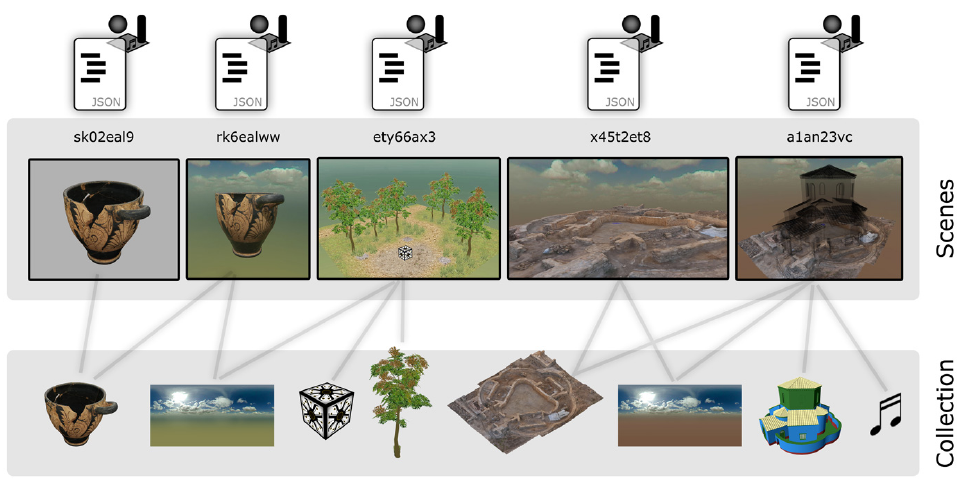
Figure 4. Scenes and